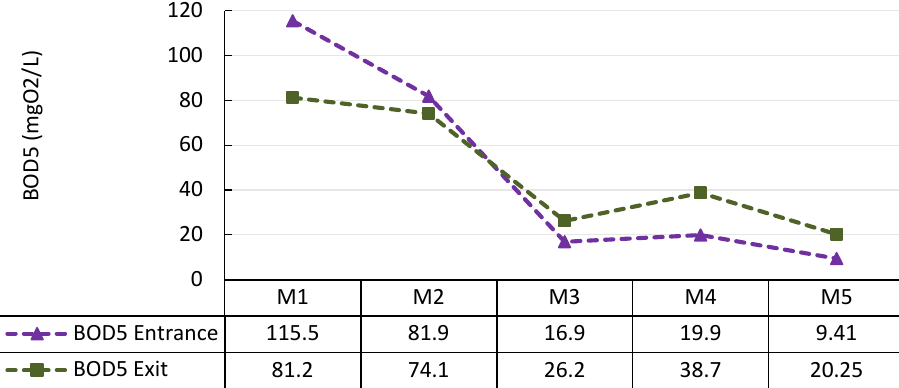
Fig. 6: Biochemical oxygen demand of the treated and untreated effluents in the 5 samplings